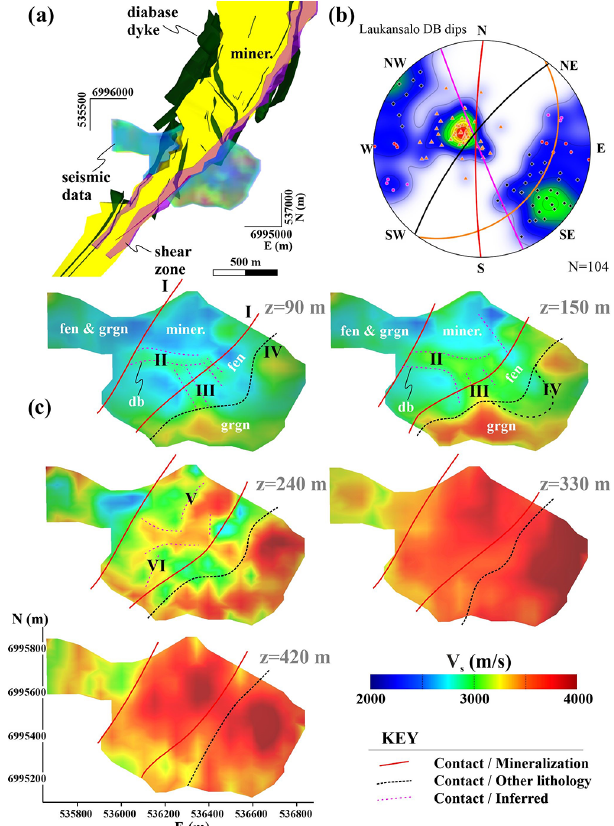
Figure 12. Geological interpretation of the final S-wave velocity model. (a) Overview of the area of the seismic investigation and the geological model of the site (from Yara). (b) Lower hemisphere stereographic projection of poles to the diabase contacts available from oriented diamond drill hole data. The great circles represent mean orientations of the four recognized diabase dike sets. (c) Level images of the seismic data with geological interpretation of the main lithological boundaries. miner. – carbonatite–glimmerite mineral- ization, fen – fenite, db – diabase and grgn –